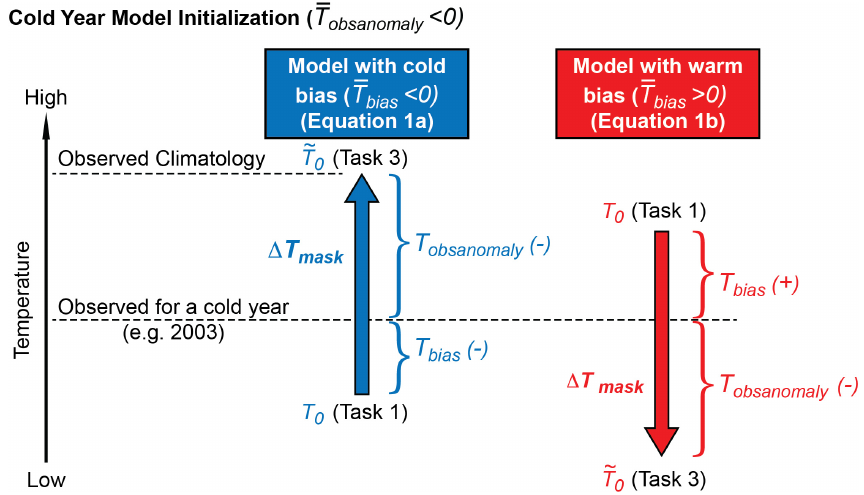
Figure 2. Schematic diagram for an imposed mask for surface temperature initialization in Task 3 corresponding to a cold anomaly year. Notes. (1) The part with blue/red color has bias and anomaly over the area with the same/different signs, respectively. (2) The ± sign in the parentheses indicates that the value is positive/negative, respectively. The notation “ = T obs anomaly (–)” indicates that it has the same value as the observed negative anomaly. (3) For simplicity, Fig. 2 is only for the grid points in which a sign of the bias is the same as the sign of area-averaged bias. (4) T 0 is the initial condition for Task 1, and ˜ T 0 is the initial condition after imposing the mask for Task